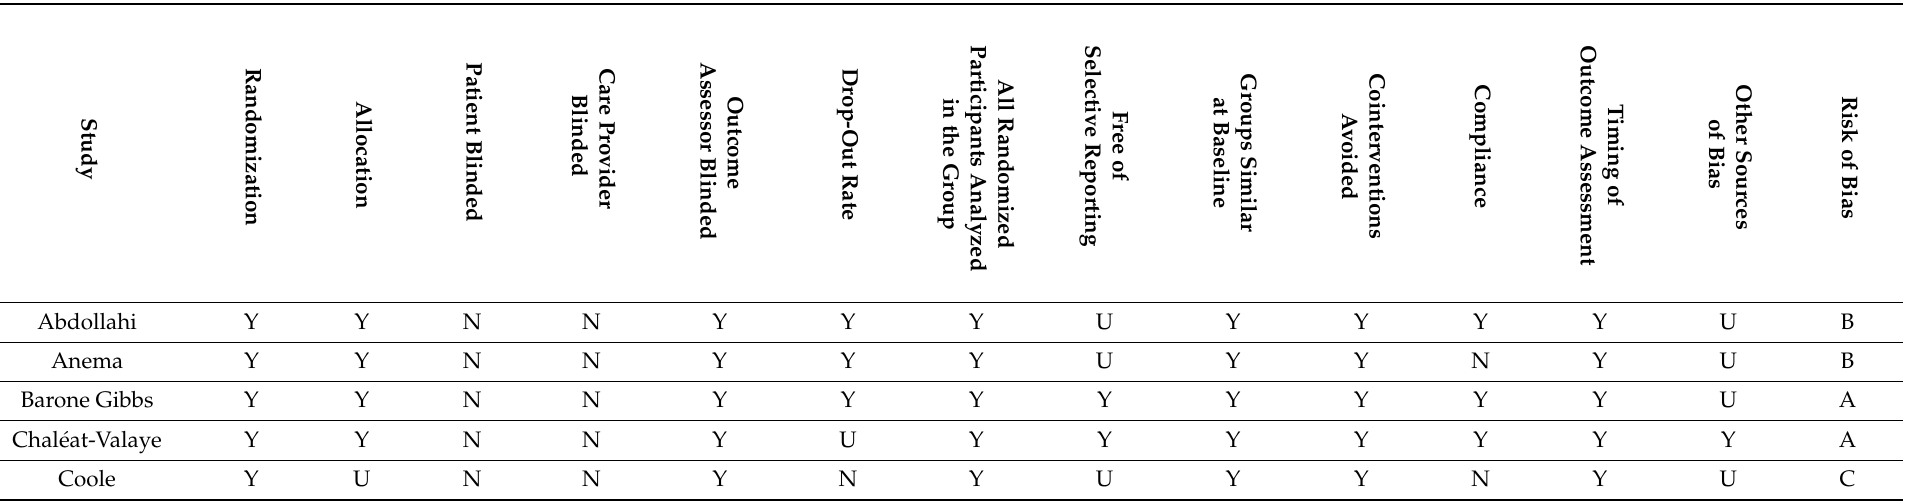
Table 2. Guideline for systematic reviews in the Cochrane back and neck